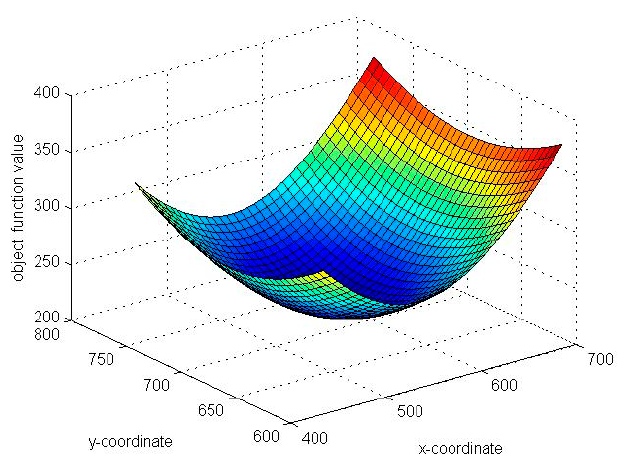
Figure 4. The surface plot of the objective function.